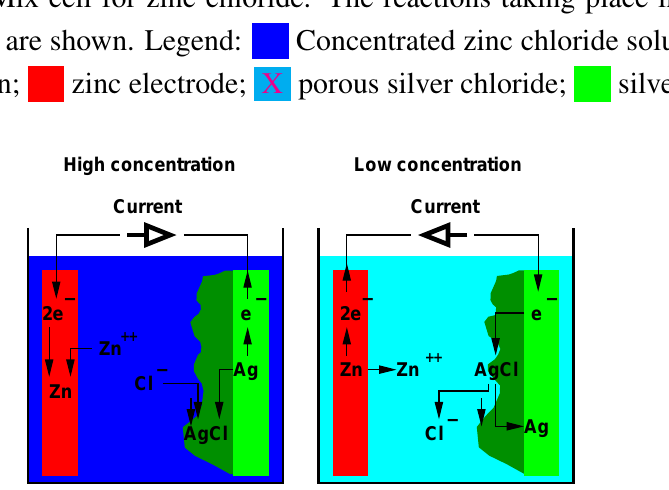
Figure 3. The AccMix cell for zinc chloride. The reactions taking place in the two steps of the AccMix cycle are shown. Legend: O Concentrated zinc chloride solution; O dilute zinc chloride solution; O zinc electrode; X porous silver chloride; O